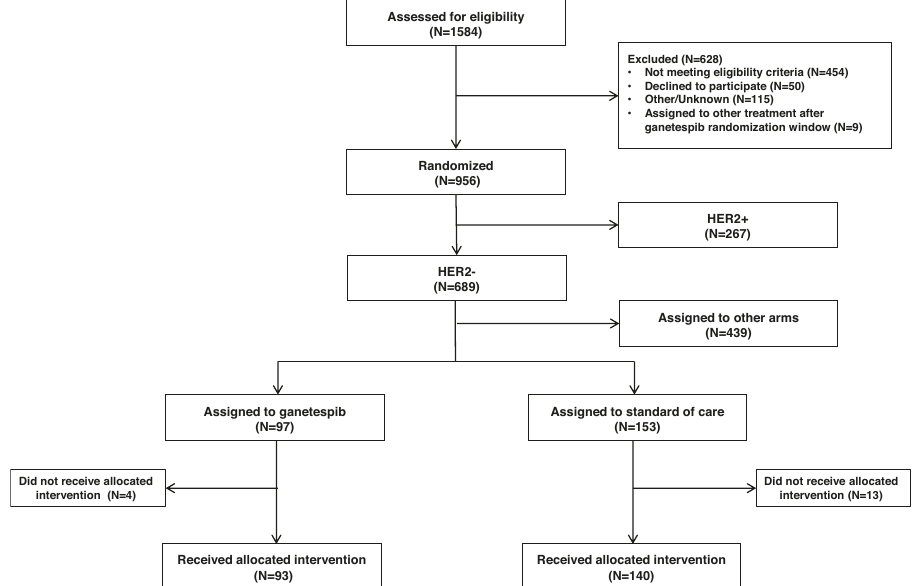
Fig. 1 CONSORT diagram. Details of the screening, randomization, and treatment for patients assigned to ganetespib or standard of care are provided.